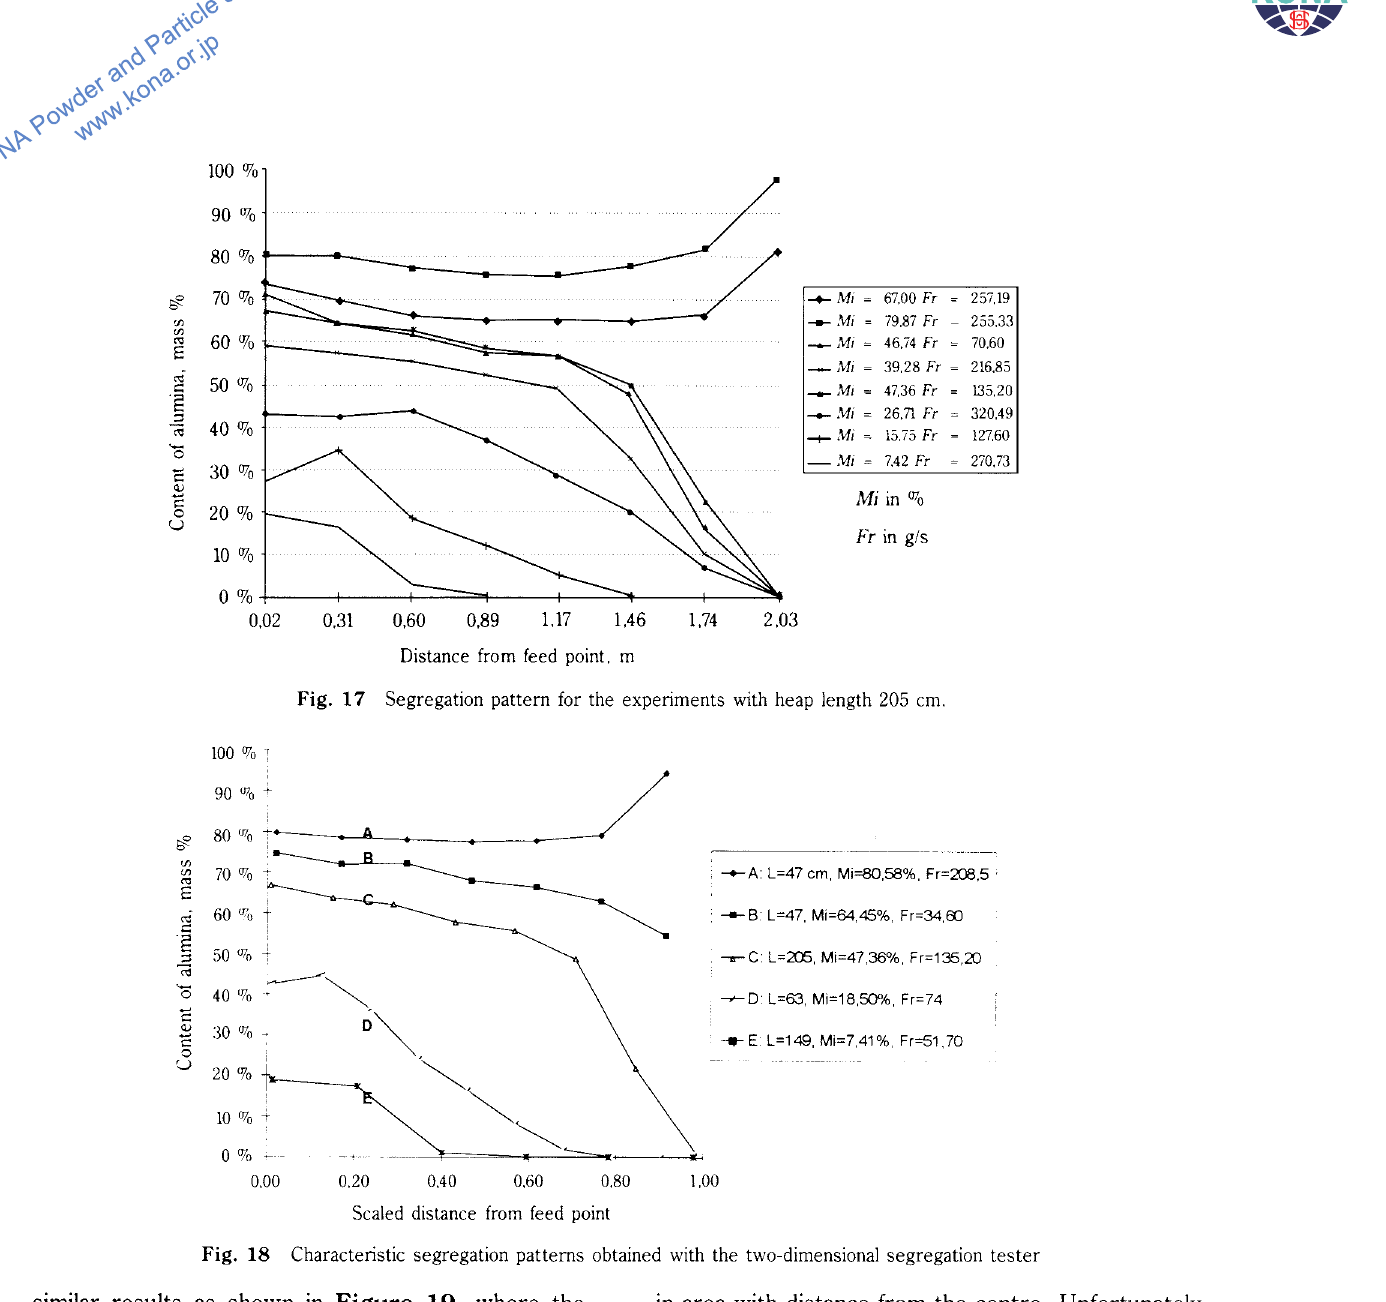
Fig. 17 Segregation pattern for the experiments with heap length 205 em.